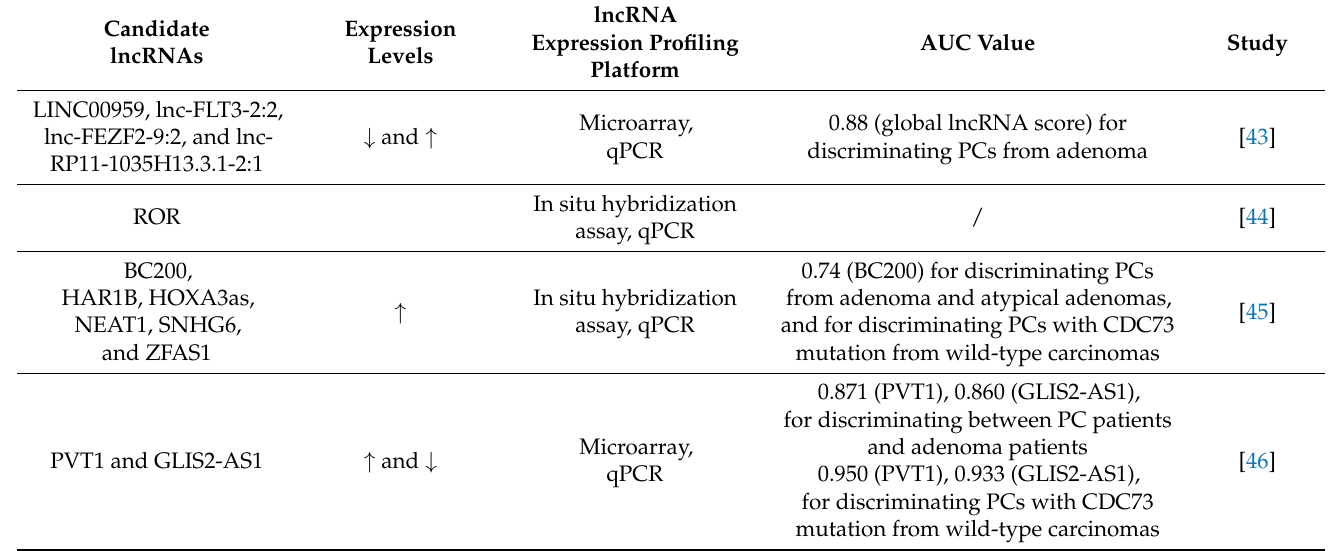
Table 2. Summary of differentially expressed lncRNAs in parathyroid